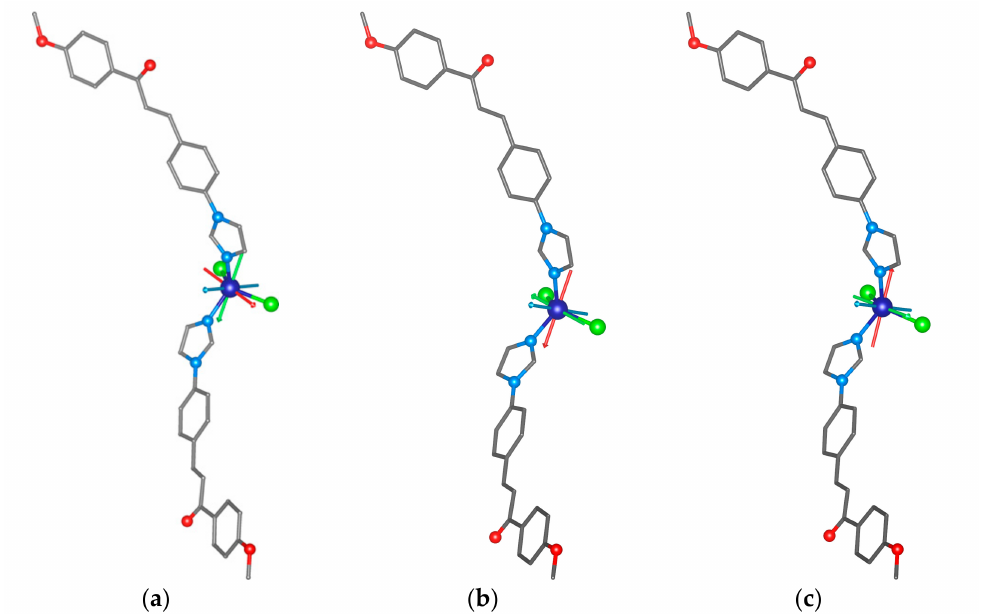
Figure 9. The CASSCF / NEVPT2 calculated principal axes of the D -tensor labeled D X (red), D Y (green), and D Z (blue) visualized together with molecular structures of 1 ( a ), Geometry 1 ( b ), and Geometry 2 ( c